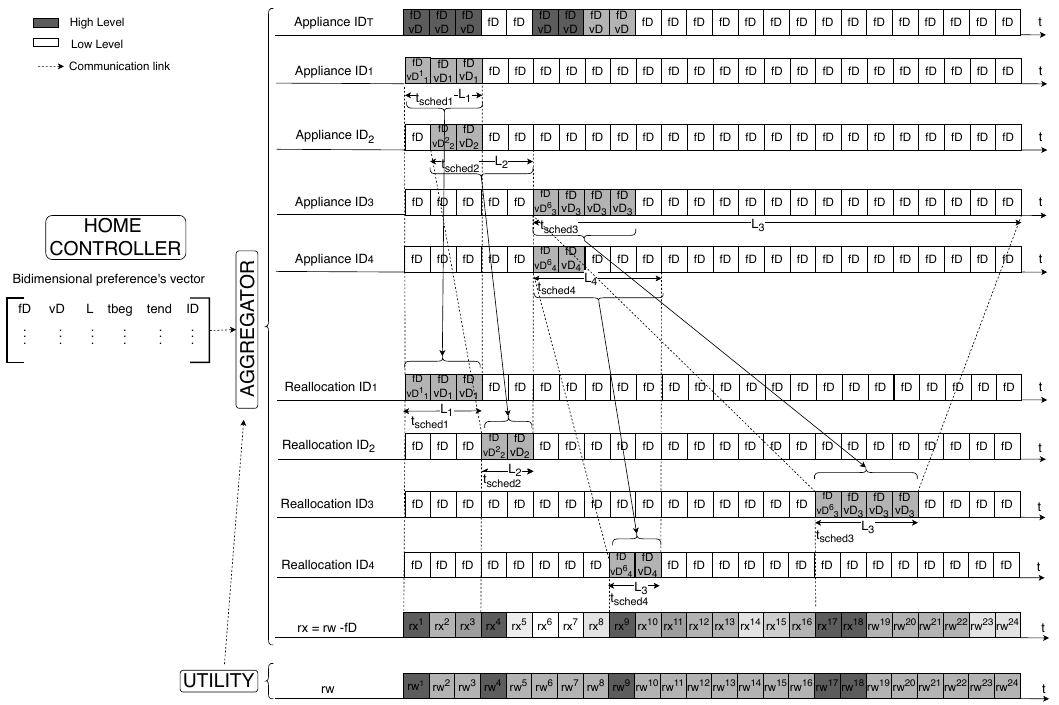
Figure 6. Local search on the 24 slot array of demand per appliance and their corresponding re-allocated array. Notation: Variable slot appliance